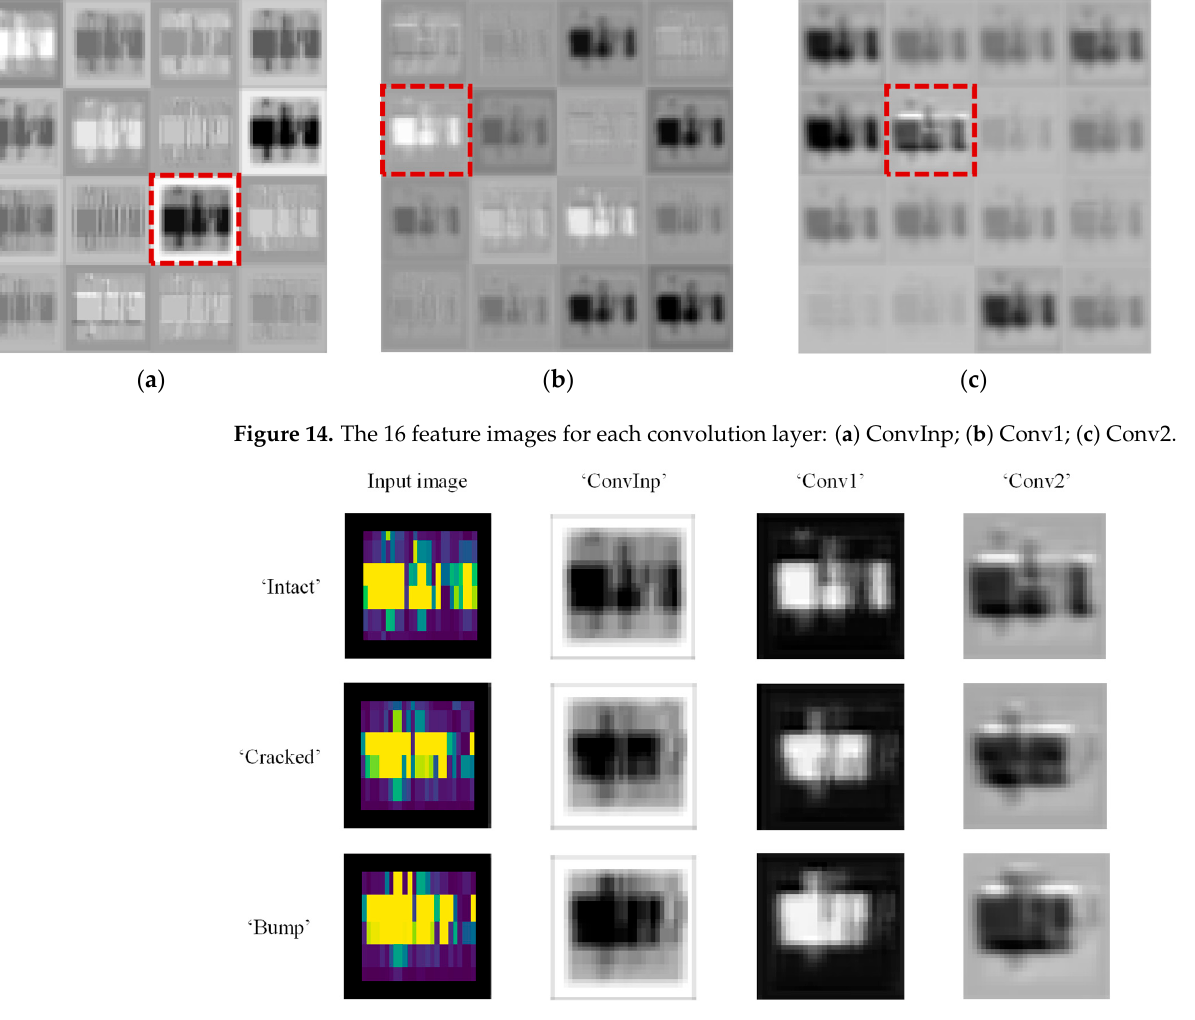
Figure 15. Visualization of the feature extraction results of each convolutional layer for each class.